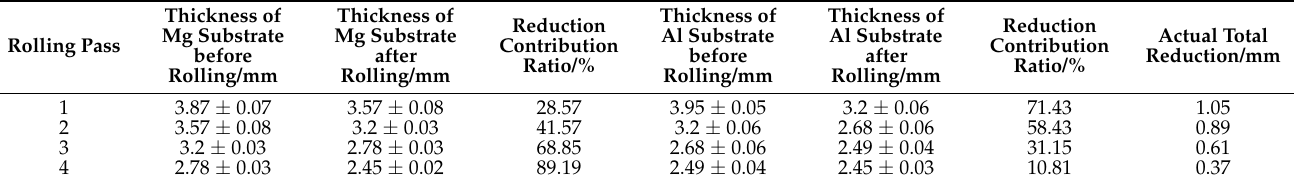
Figure 4. Thickness values of different rolling passes of Al and Mg substrates. Table 3. Contribution of Al and Mg to a reduced rate of composite